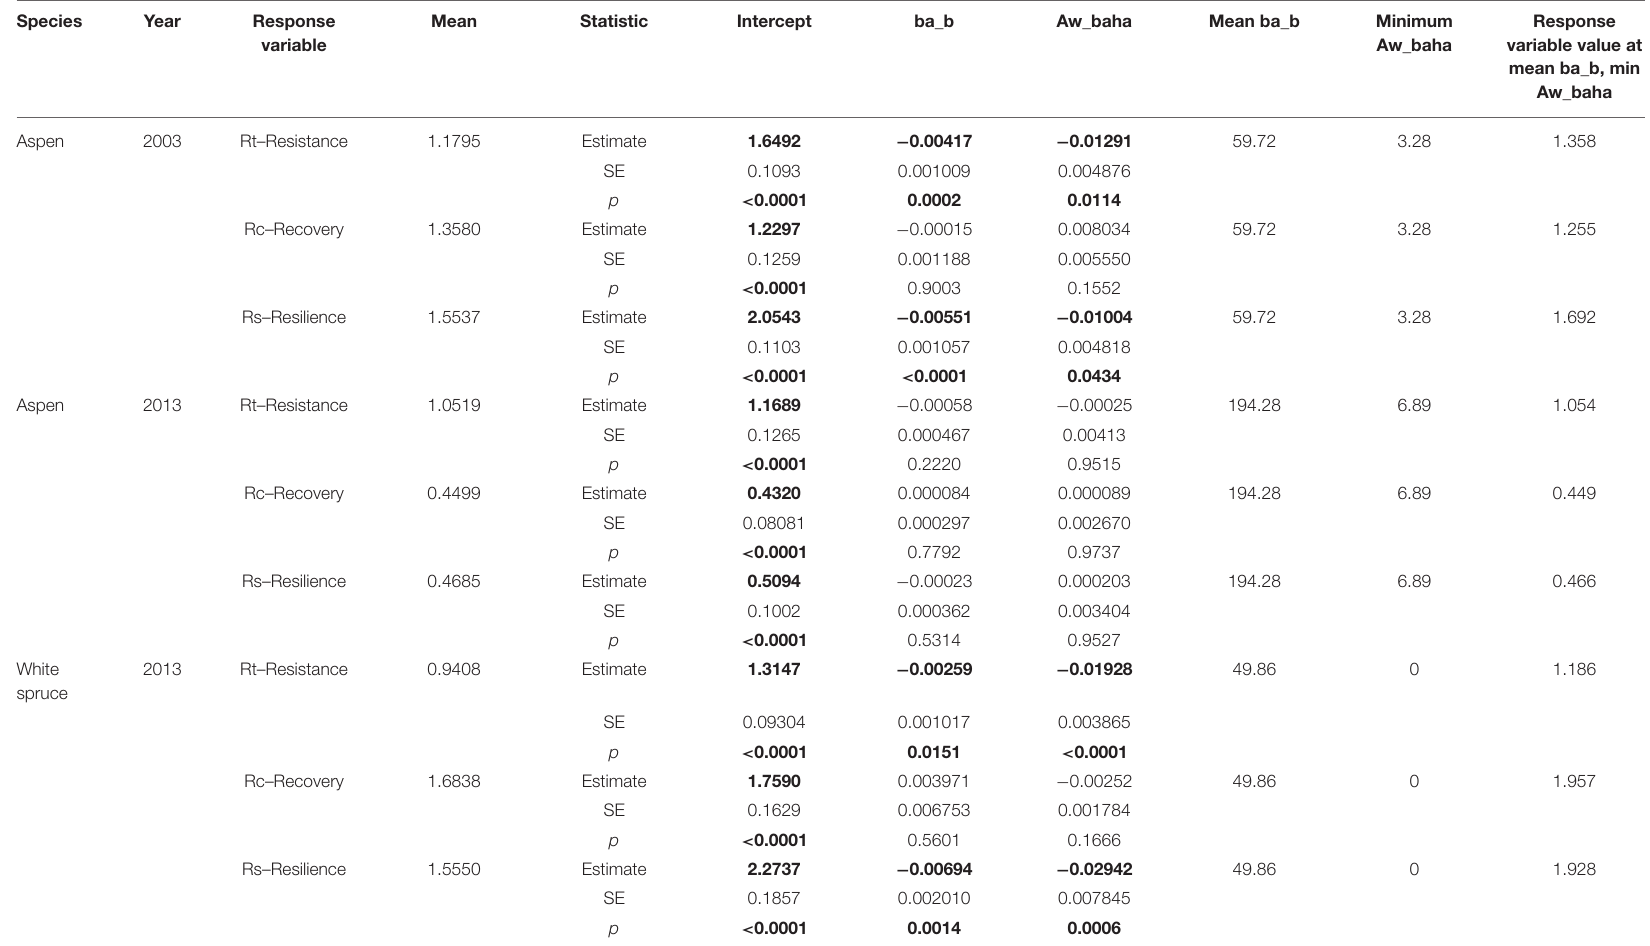
TABLE 5 | Results from linear mixed-effects model examining effects of tree size (basal area) and aspen stand level basal area on tree drought responses in 2003 and 2013 for trembling aspen and white spruce.